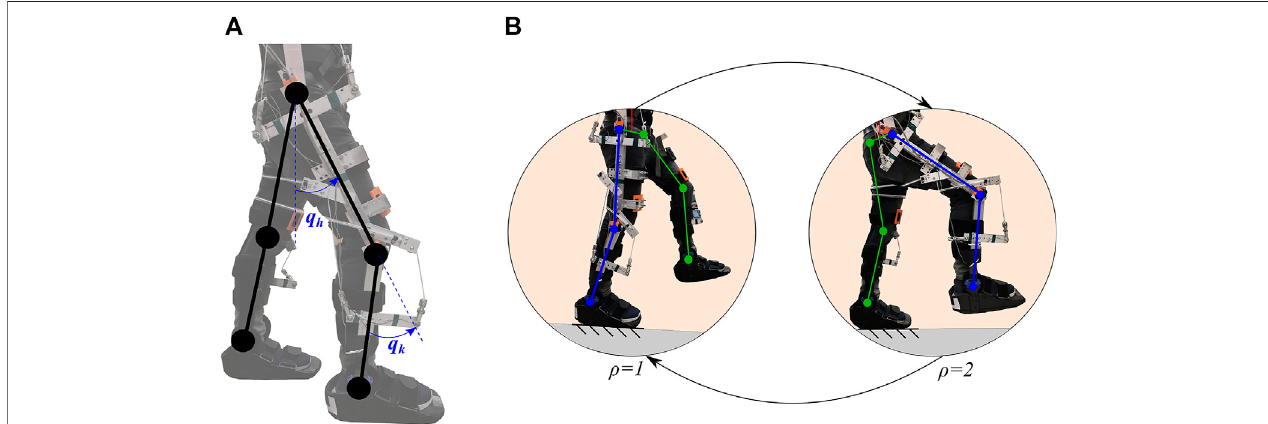
FIGURE 1| Schematic ofthe human-exoskeleton system withswitching dynamics. (A) The knee jointangle q k and hip joint angle q h ofthe right leg are depicted in aninitialstandingposition. (B) Theswitchingdynamicsareillustratedusingthestancelegasreference(i.e.,supportleg).Thesubsystem ρ (cid:2) 1denoteswhentherightleg is in the stance phase and the left leg is in the swing phase. The subsystem ρ (cid:2) 2 denotes when the left leg is in the stance phase and the right leg is the swing phase.